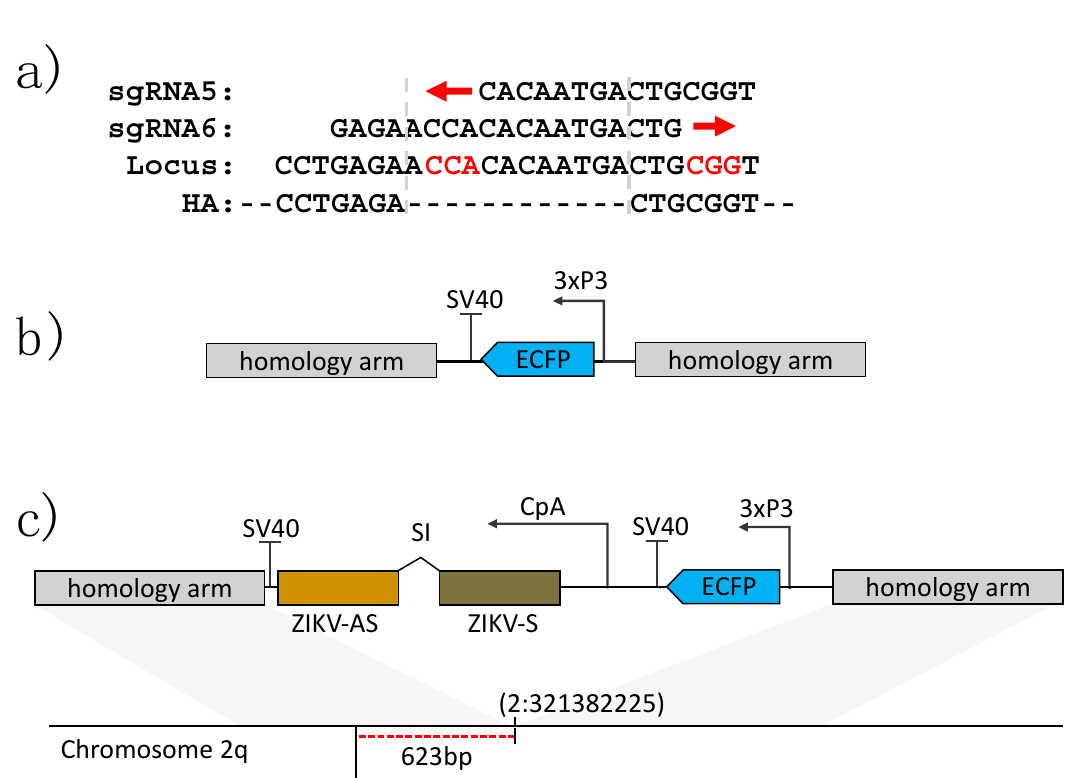
Figure 2. Schematic illustrations of sgRNAs and plasmids used in this study for CRISPR / Cas9 site-specific insertion. ( a ) Nucleotide sequences of sgRNAs (sgRNA5 and sgRNA6), their genomic target sequence, and the junctions of the flanking homology arms (HA) used for transgene integration into the Chr2:321382225 site. The red arrows indicate the directionality of the protospacers, while the respective PAM sequences are displayed in red text. ( b ) 3xP3-ECFP-SV40 donor used to test CRISPR / Cas9 mediated insertion e ffi ciency. ( c ) ZIKV-targeting IR construct. CpA = carboxypeptidase A promoter, ECFP = enhanced cyan fluorescent protein, 3xP3 = eye-specific promoter, SV40 = large T antigen terminator from simian virus 40 used as a polyadenylation signal, ZIKV-AS = antisense cDNA of the anti-ZIKV IR e ff ector, ZIKV-S = sense cDNA of the anti-ZIKV IR e ff ector, SI = small intron of the Ae. aegypti sialokinin1